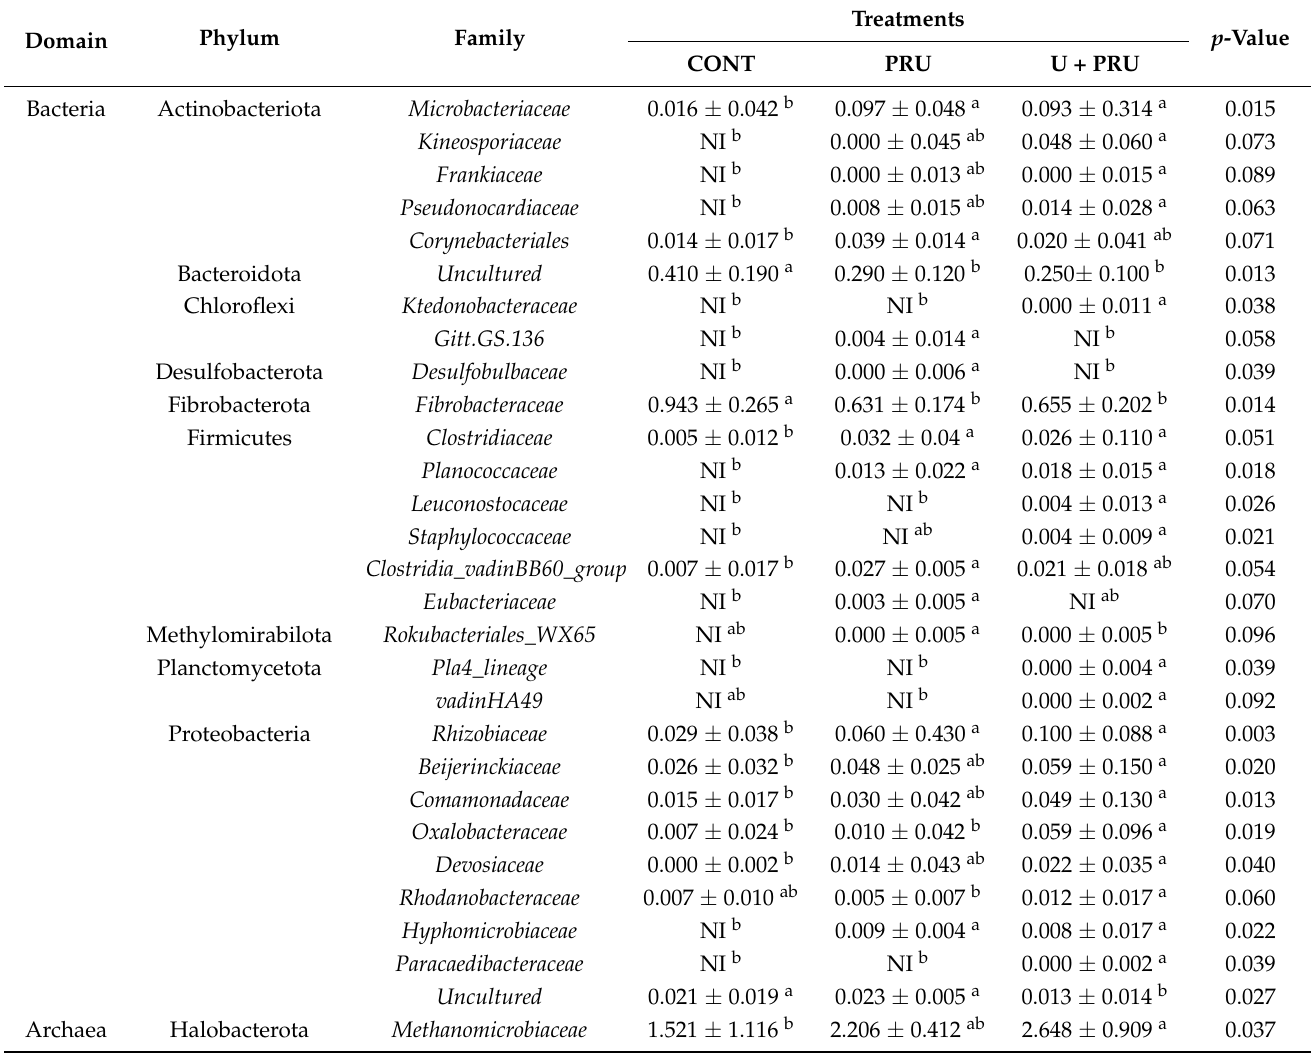
Table 7. Median and interquartile range of the relative abundance of the families in Nellore steers, influenced by post-ruminal urea in relation to conventional urea during the dry